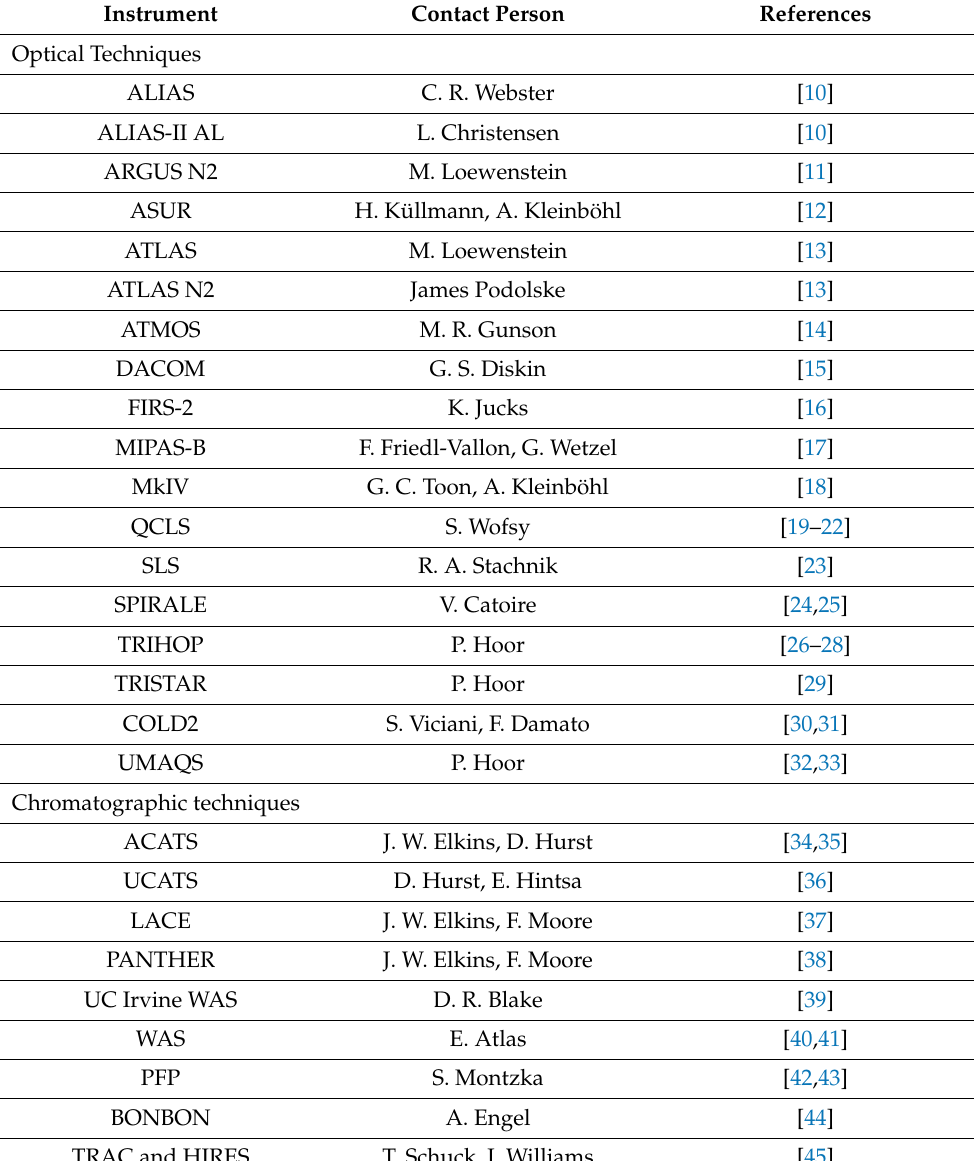
Table 1. Instruments list and